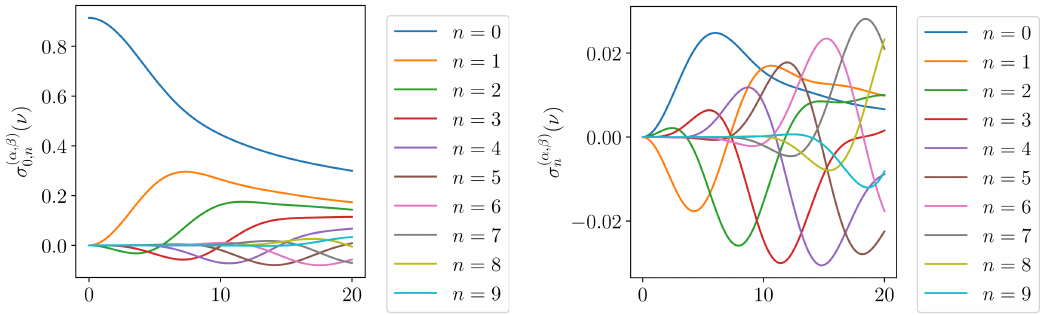
Figure 1 . The functions σ ( α,β ) ( ν ) (Left) and σ (NLO) n ( ν, z 2 µ 2 ) = σ ( α,β ) n ( ν, z 2 µ 2 ) − σ ( α,β ) ( ν ) (Right) 0 ,n 0 ,n for α = − 0 . 5 and β = 3 over a range of n . For the NLO contribution, the value of z 2 = 4 ∗ 0 . 065 fm, µ = 2 GeV, and α s = 0 . 3 were chosen as a typical example which will be used in this study. The peaked structures of σ ( α,β ) and σ (NLO) n mean that only certain n significantly contribute in the 0 ,n limited range of Ioffe time. The size of σ (NLO) n , relative to σ ( α,β ) , leads to a small perturbative 0 ,n contribution as desired.